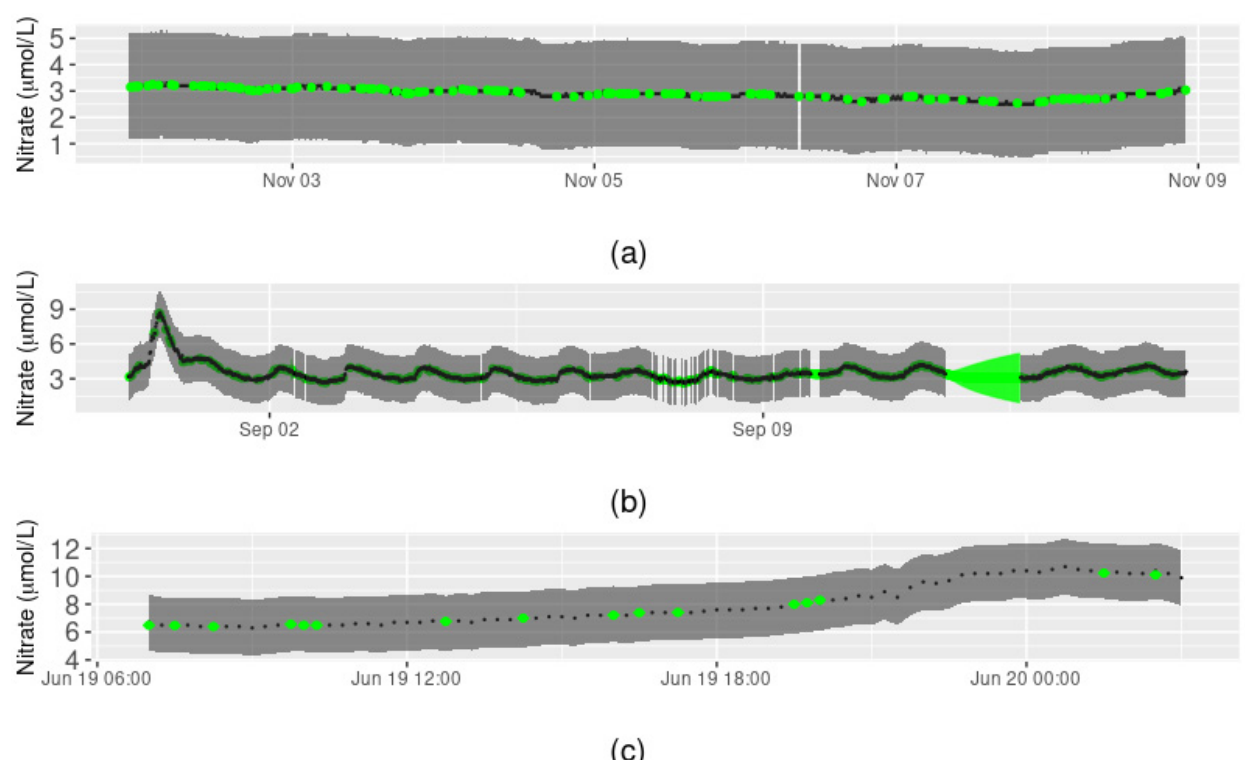
Figure 5. Performance evaluation: missing point data examples. Examples for different periods of randomly removed point observations, simulated 100 times: ( a ) one week, ( b ) one month, and ( c ) a nitrate event in which concentrations rose rapidly in less than 24 h. Dark points represent the real nitrate concentration value and the grey shading around those points represents the precision interval of the sensor. Green points and shading are the predicted values along with the prediction interval. Prediction intervals may not be visible when they are narrow relative to the precision interval of the sensor.